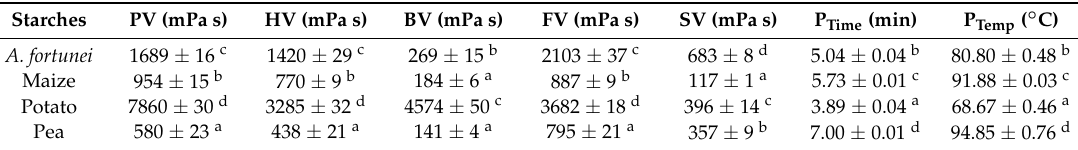
Table 5. Pasting parameters of starch.